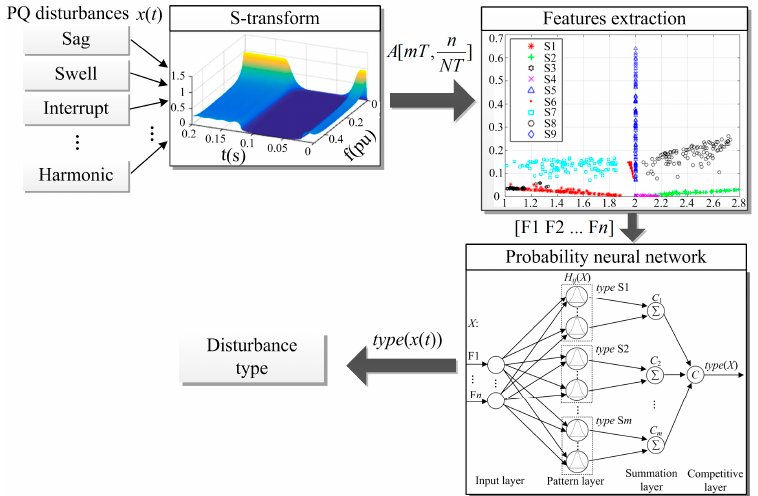
Figure 1. The schematic diagram of power quality (PQ) disturbance classification using S-transform and probabilistic neural network (PNN).